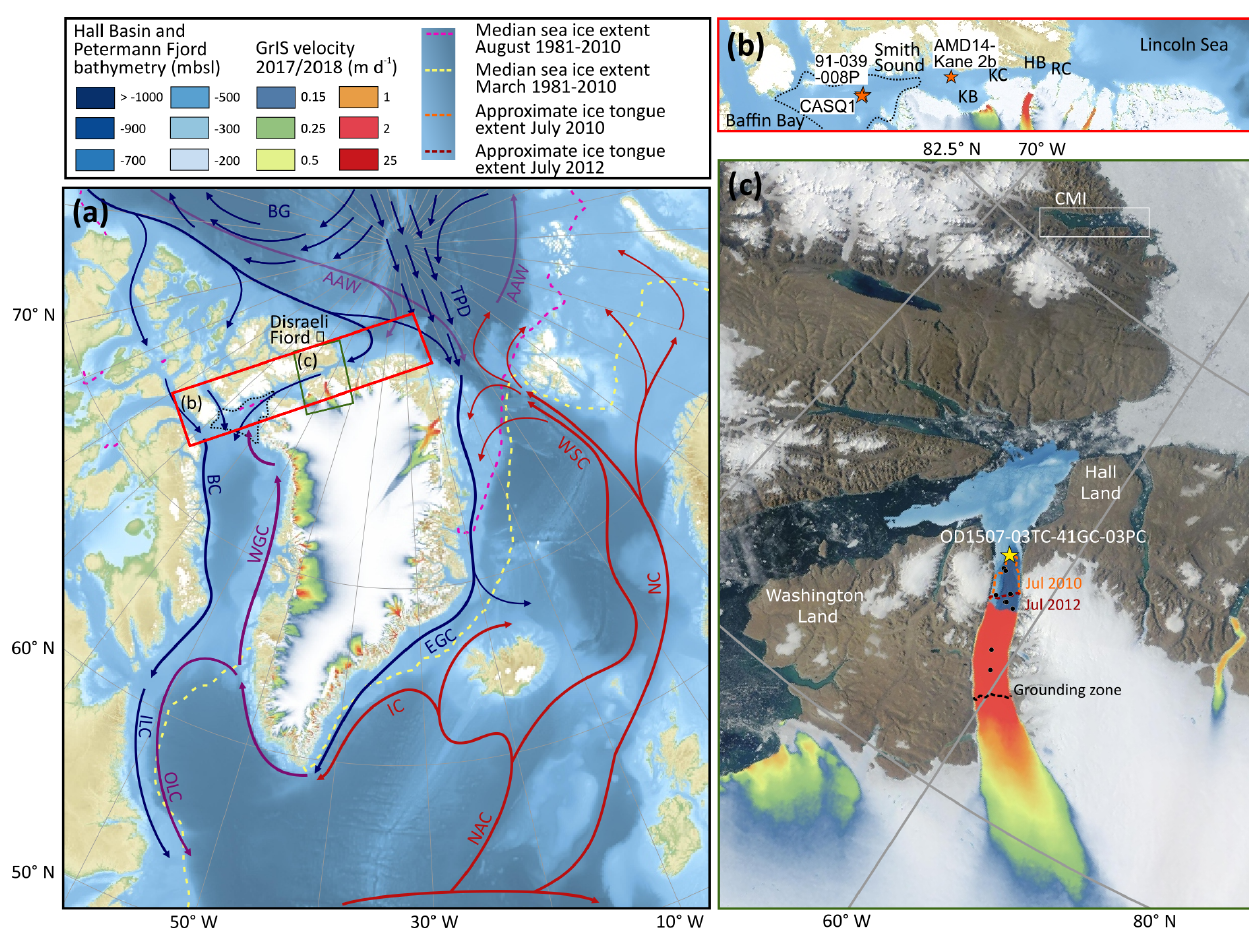
Figure 1. Map of the study area. (a) Map of the North Atlantic, including major surface currents (AW: modified Atlantic Water; BC: Baf- fin Current; BG: Beaufort Gyre; EGC: East Greenland Current; IC: Irminger Current; ILC: Inner Labrador Current; NAC: North Atlantic Current; NC: Norwegian Current; OLC: Outer Labrador Current; TPD: Transpolar Drift; WGC: West Greenland Current; WSC: West Spits- bergen Current), median August (dashed, pink) and March (dashed, yellow) sea ice extent from 1981–2010 (Fetterer et al., 2017), the velocity of the Greenland Ice Sheet (GrIS) 2016/2017 (Nagler et al., 2015), and the location of Disraeli Fiord (Ellesmere Island). The approximate ex- tent of the NOW polynya (mean extent in May 1954–1968) (Dunbar, 1969) is indicated with a black dashed line. (b) Close-up of Nares Strait, connecting Lincoln Sea to northern Baffin Bay, consisting of Robeson Channel (RC), Hall Basin (HB), Kennedy Channel (KC), Kane Basin (KB), and Smith Sound. The red stars indicate additional sediment cores discussed in this paper. These are AMD14-Kane2b (Kane Basin; Georgiadis et al., 2020), CASQ1 (central NOW; Jackson et al., 2021), and 91-039-008P (central NOW; Knudsen et al., 2008). (c) Close up of the Petermann Fjord and Petermann glacier (satellite image from “NASA Worldview” https://worldview.earthdata.nasa.gov/, last access: 19 February 2020) including the location of Clements Markham Inlet (CMI), the Hall Basin and Petermann Fjord bathymetry (Jakobsson et al., 2018), the velocity of the Greenland Ice Sheet (GrIS) 2016/2017 (Nagler et al., 2015), the grounding zone location of Petermann glacier (black, dashed), and the ice tongue extent in July 2010 (orange, dashed) and 2012 (red, dashed). The core location of OD1507-03TC-41GC- 03PC is indicated with a yellow star, and the black dots show additional core sites from the Petermann 2015 expedition used in Reilly et al. (2019) to reconstruct the Holocene extent of the PG ice